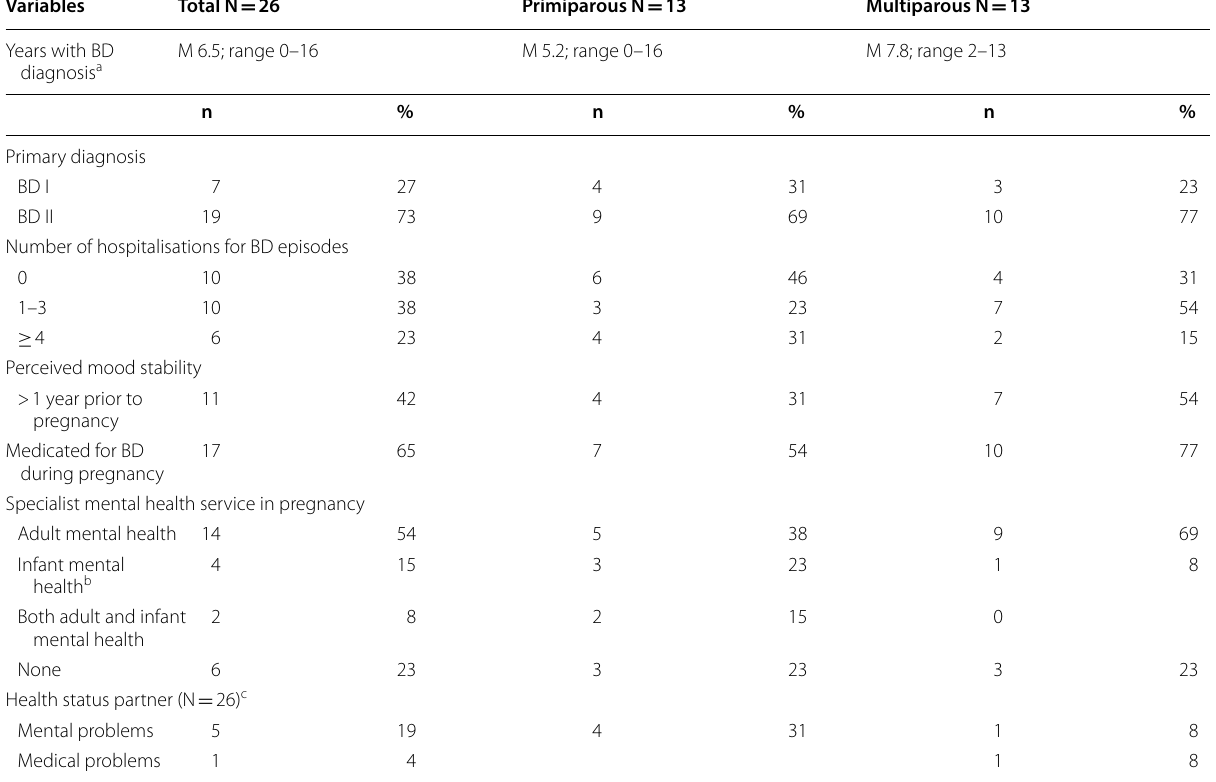
Table 2 Clinical characteristics of the sample and the health status of